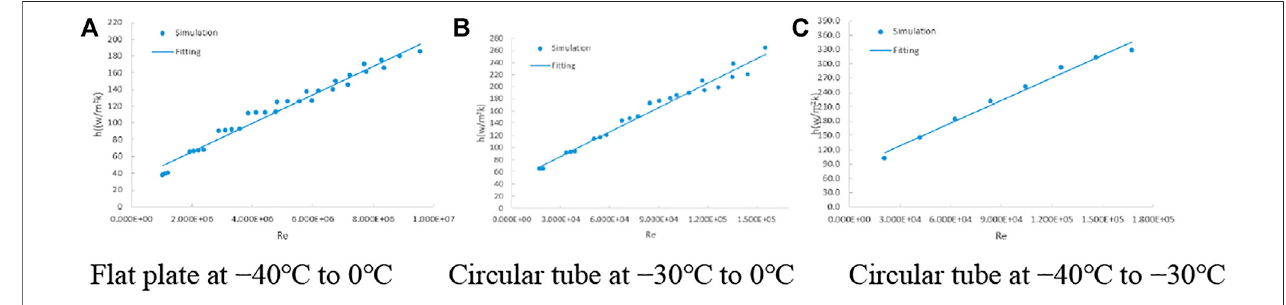
FIGURE 7 | Simulation data fi tting of convective heat transfer coef fi